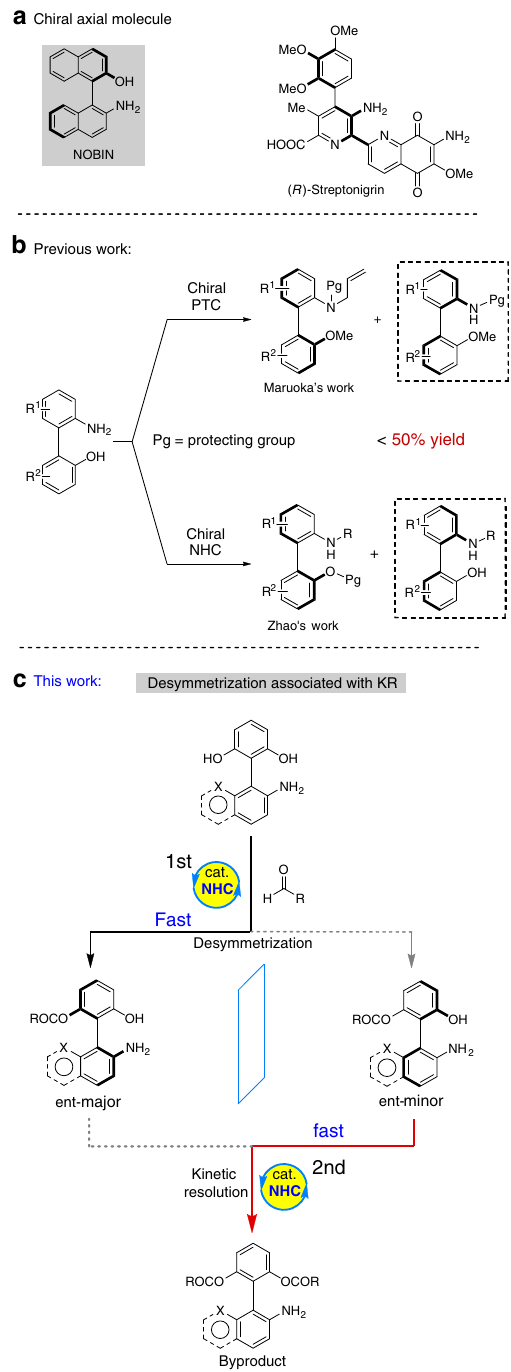
Fig. 1 Representative molecules and synthetic protocols. a Two representative axially chiral molecules. b Asymmetric kinetic resolution of achiral biaryl amino alcohols. c Our synthetic proposal via a NHC-catalyzed atroposelective synthesis of axially chiral biaryl amino-alcohols via a cascade strategy of desymmetrization followed by kinetic